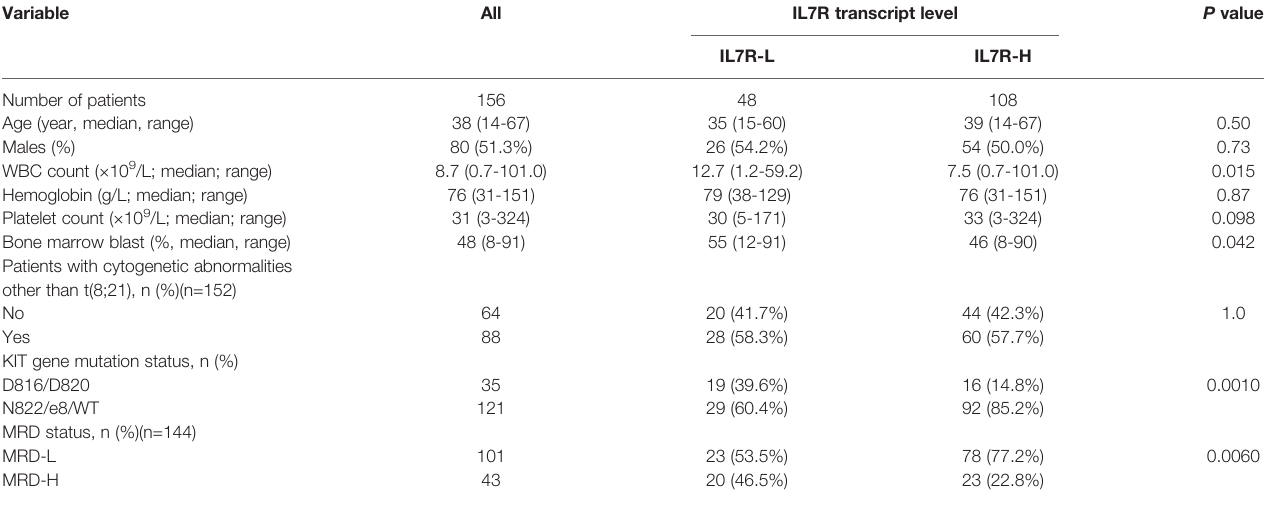
TABLE 1 | Relationship between IL7R expression at diagnosis and other characteristics. Variable